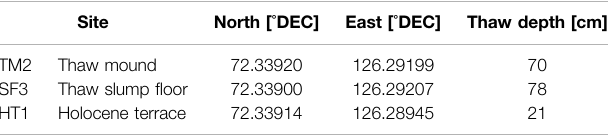
TABLE 1 | Sampling locations on Kurugnakh Island and thaw depth (measured in August